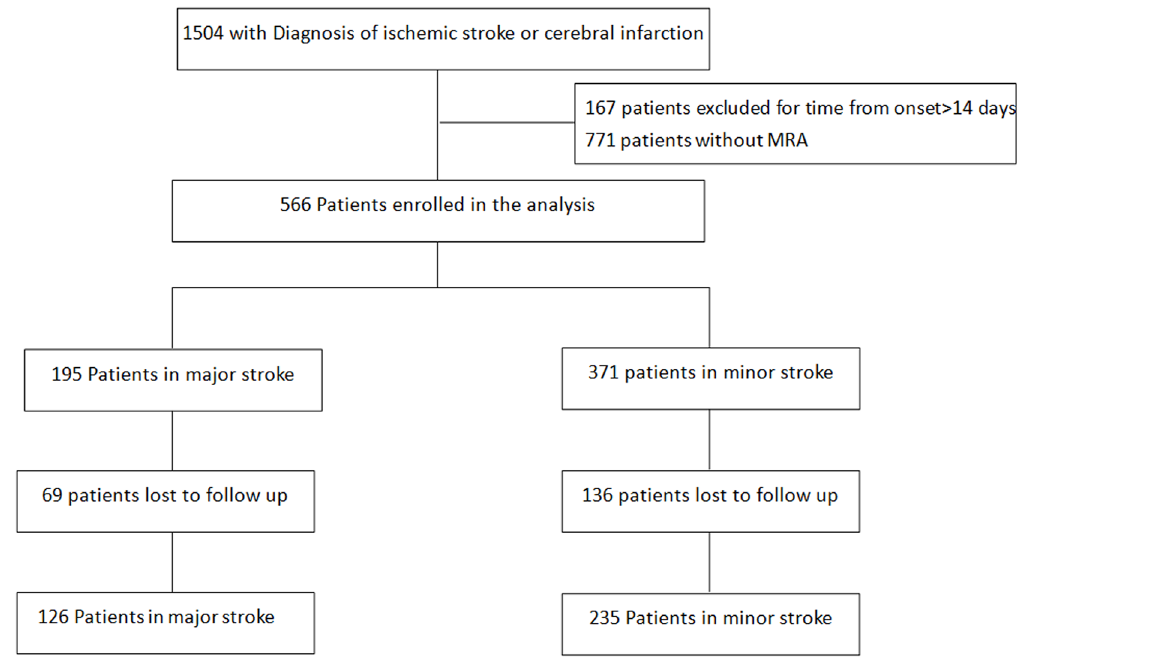
Fig 1. Flow Chart of the Patients